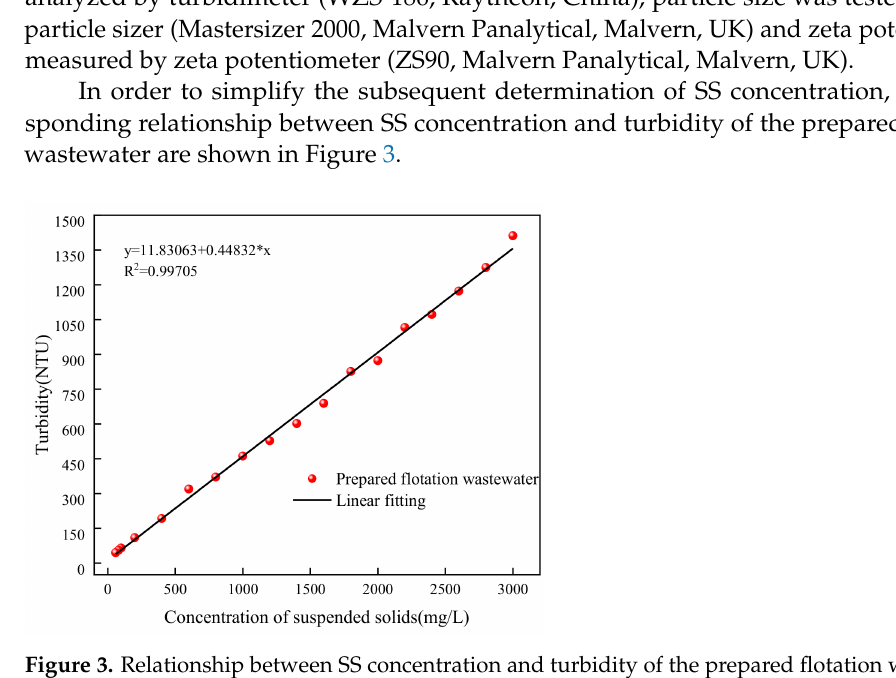
Figure 3. Relationship between SS concentration and turbidity of the prepared flotation